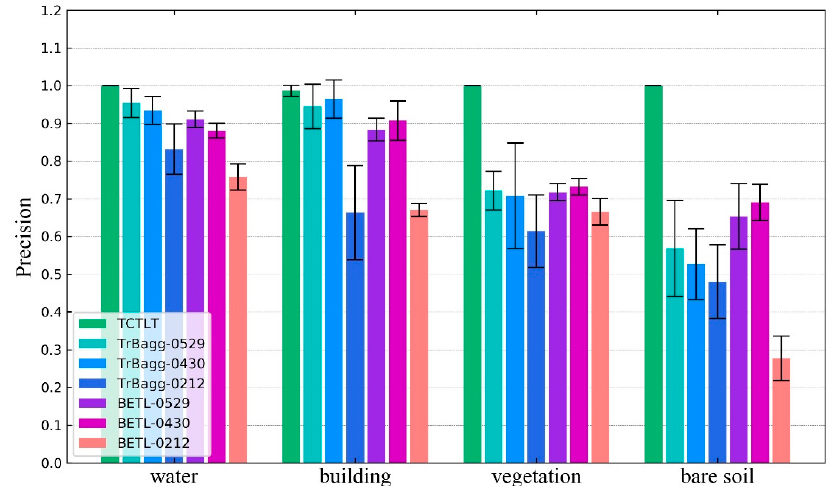
Figure 6. The mean and standard deviation of the label transfer precision of different objects.